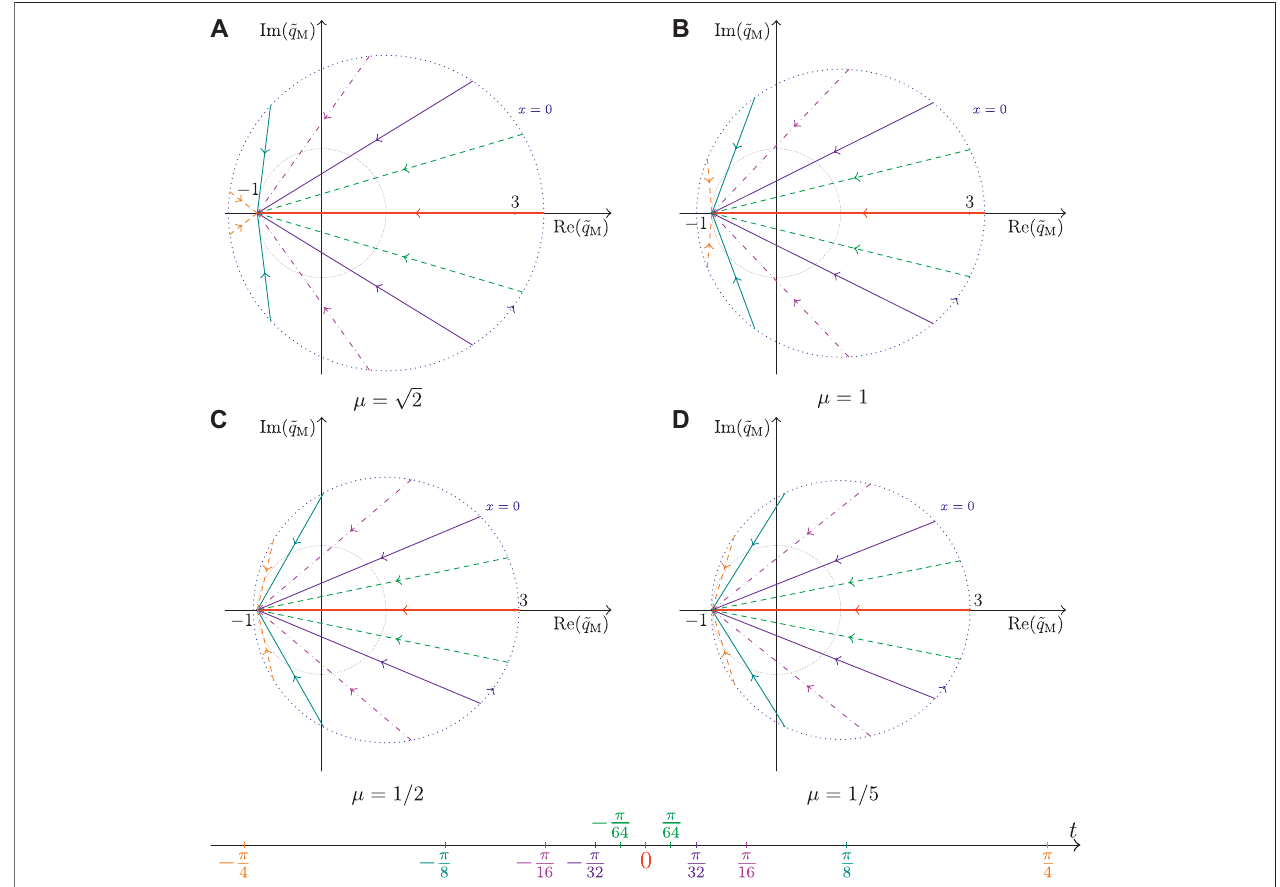
FIGURE 4 | Parameterization of the non-rapid-oscillating complex-valued amplitude of the Kuznetsov-Ma breather ~ q M in the spatial variable x , x ≥ 0, for different values of temporal variable t and different values of the parameter μ : (A) μ (cid:2) t (cid:2) ± π / 64 (dashed green), t (cid:2) ± π / 32 (solid purple), t (cid:2) ± π / 16 (dash-dotted magenta), t (cid:2) ± π / 8 (solid cyan), and t (cid:2) ± π / 4 (dashed